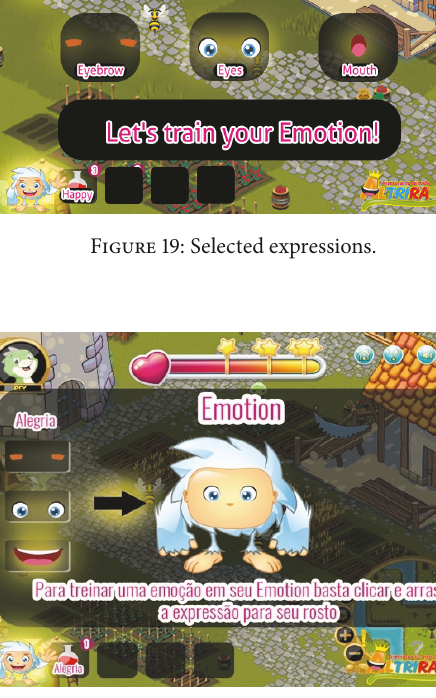
Figure 20: Training